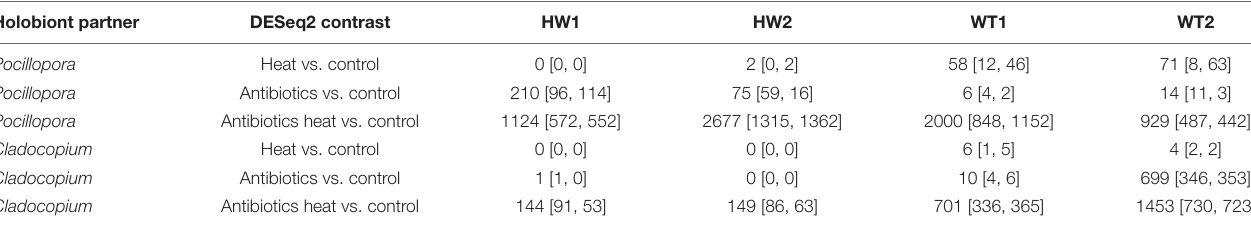
TABLE 2 | Number of Pocillopora and Cladocopium DEGs (# of genes DESeq2 p adj < 0.05 [up, down]) detected in contrasts between each experimental treatment and the control treatment for each genotype and all genotypes together. Holobiont